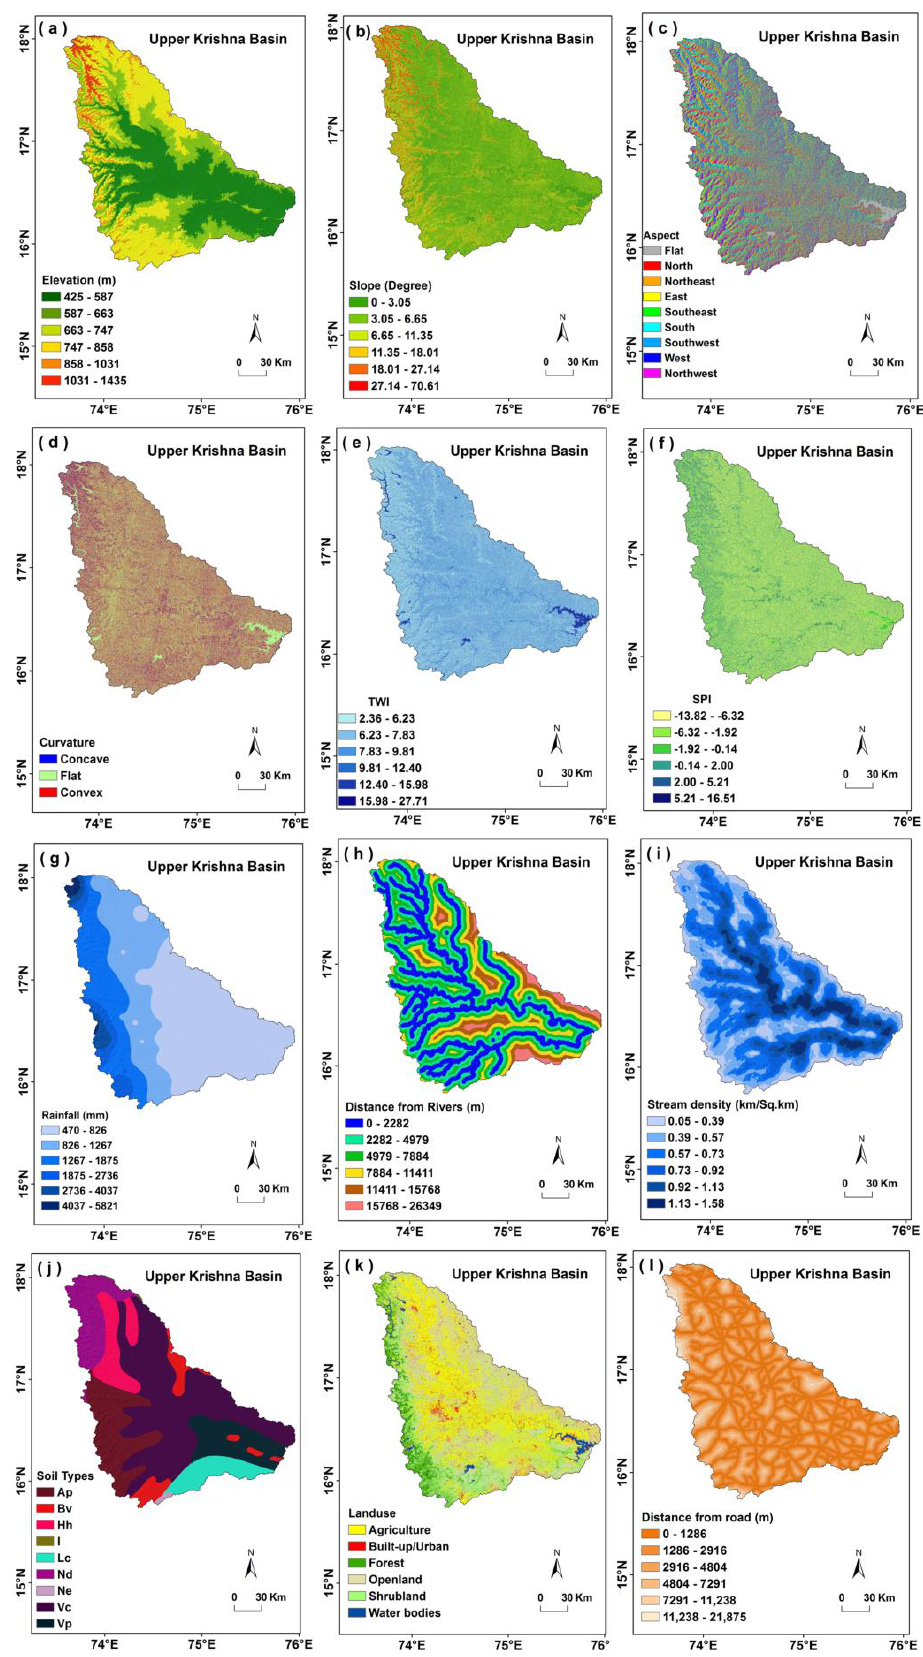
Figure 4. Flood controlling factors used for flood susceptibility